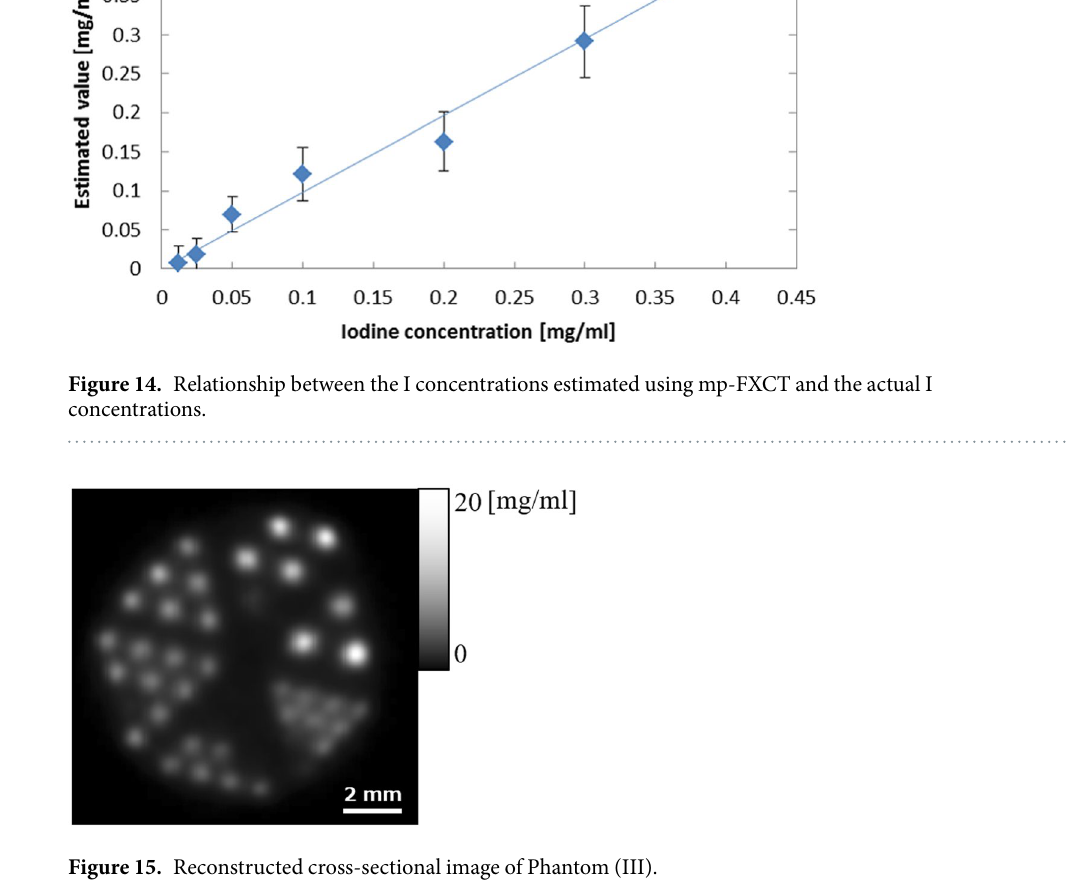
Figure 16 is a 3-D VR representation of Phantom (IV). Figure 17 shows the horizontal and vertical sectional images of the reconstructed image. Although the 0.35 mm pitch of the large screw is discernible, the 0.25 mm pitch of the small screw is blurred. Thus, it can be concluded that the vertical spatial resolution of the mp-FXCT system is between 0.25 mm and 0.35 mm.